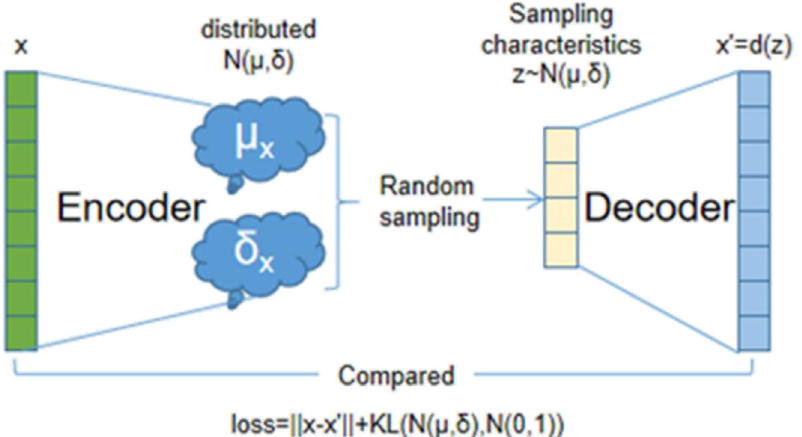
Fig. 5. Variational autoencoder structure diagram. Where x is the input data, x 0 is the reconstructed data, and m x and d x are the mean and standard deviation of normal distribution